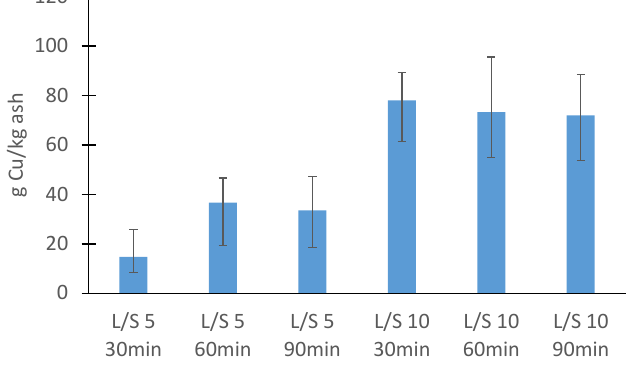
Figure 2. Cu leached from the bark-ash sample A1 with a variation in leaching time (30–90 min) and L/S-ratios (5 and 10). The columns show the average of three replicate tests. The error bars show the maximum and minimum